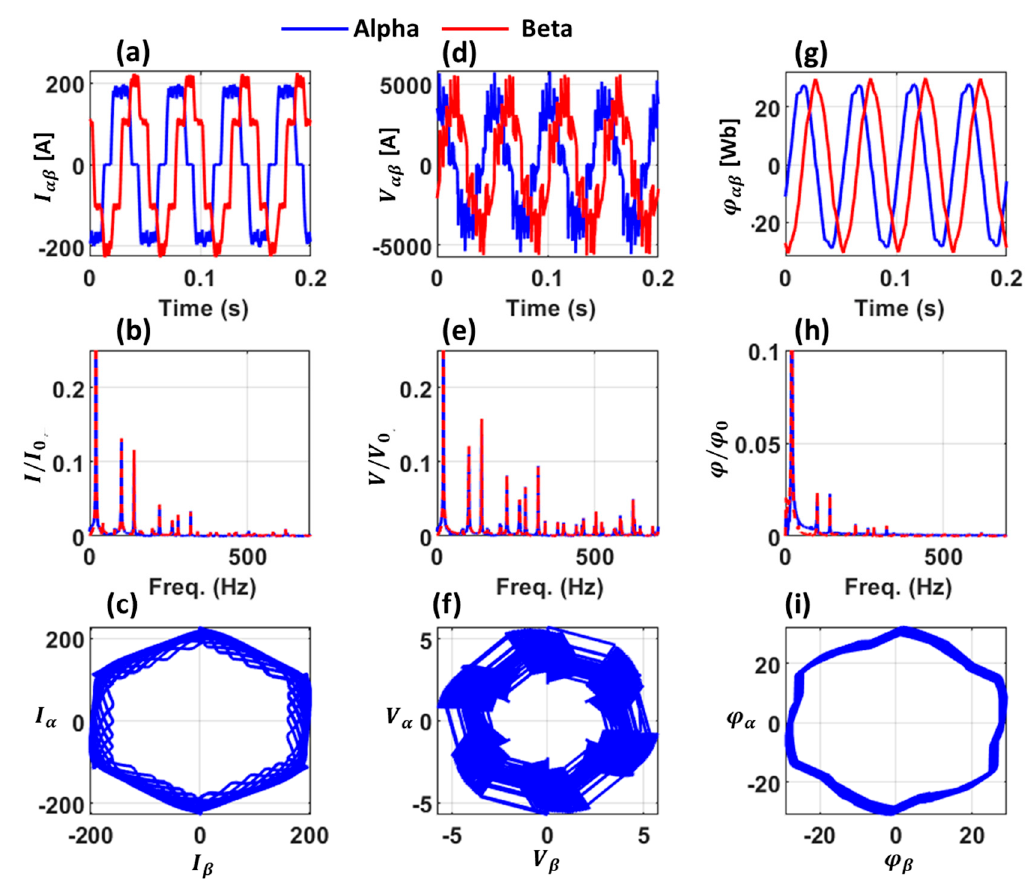
Figure 16. Sample simulation results of a 6/6-pulse LCI system at 40 Hz in alpha–beta reference frame: ( a ) motor current, ( b ) spectrum of motor current, ( c ) phasor of motor current, ( d ) motor voltage, ( e ) spectrum of motor voltage, ( f ) phasor of motor voltage, ( g ) stator flux, ( h ) spectrum of stator flux and ( i ) phasor of stator flux.